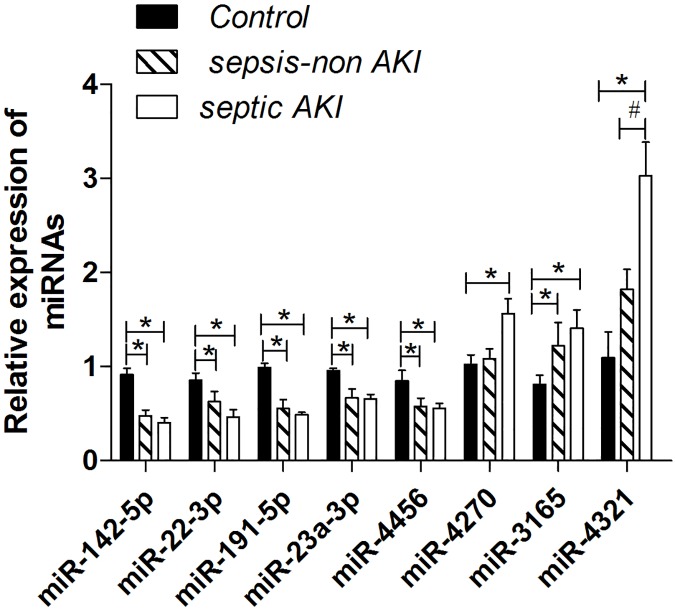
Confirmation of miRNA level by RT-qPCR.Relative expression of each miRNA was normalized to hsa-miR-423-5p level. miR-142-5p, miR-22-3p, miR-191-5p, miR-23a-3p and miR-4456 were significantly decreased in both the sepsis-induced AKI and sepsis-non AKI groups compared with the healthy controls. miR-4270, miR-4321 and miR-3165 were obviously increased in the sepsis-induced AKI, and miR-3165 also was obviously increased in sepsis-non AKI group compared with the healthy controls. While statistical significance between the sepsis-induced AKI and sepsis-non AKI groups was shown only on miR-4321 expression. Note: a single asterisk indicates significant difference between the healthy controls (n = 3) and the sepsis-induced AKI group (n = 6), as well as between the healthy controls and the sepsis-non AKI group (n = 6). A pound sign indicates a statistical difference between the sepsis-induced AKI group and the sepsis-non AKI group. P < 0.05 was considered statistically significant.